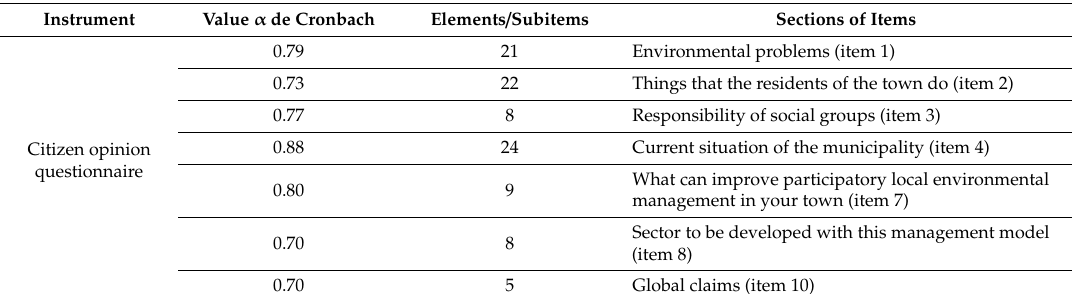
Table 4. Analysis of the reliability of the citizen opinion